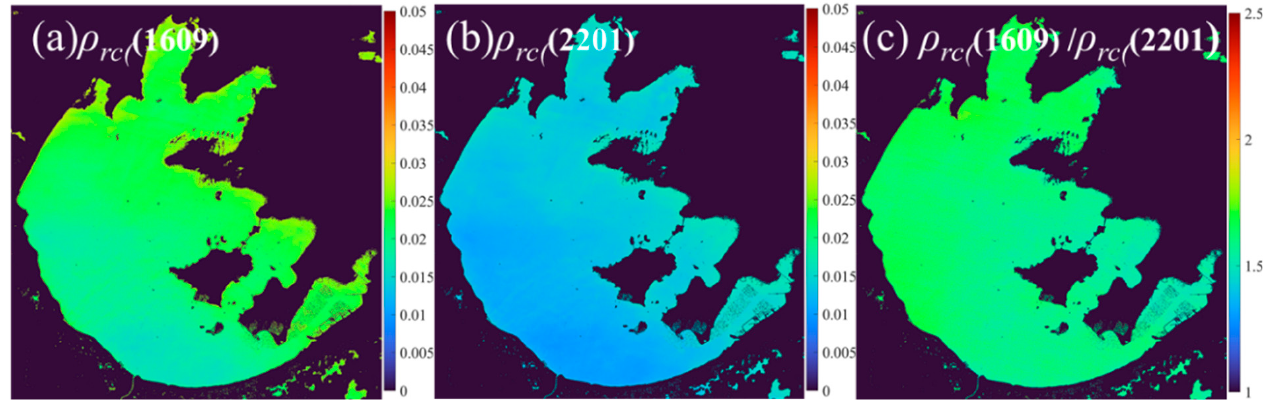
Figure 12. Rayleigh-corrected re fl ectance ( ρ rc ) in SWIR bands and its ratio ( ρ rc (1609)/ ρ rc (2201)) from Lake Taihu on 2 February 2016.